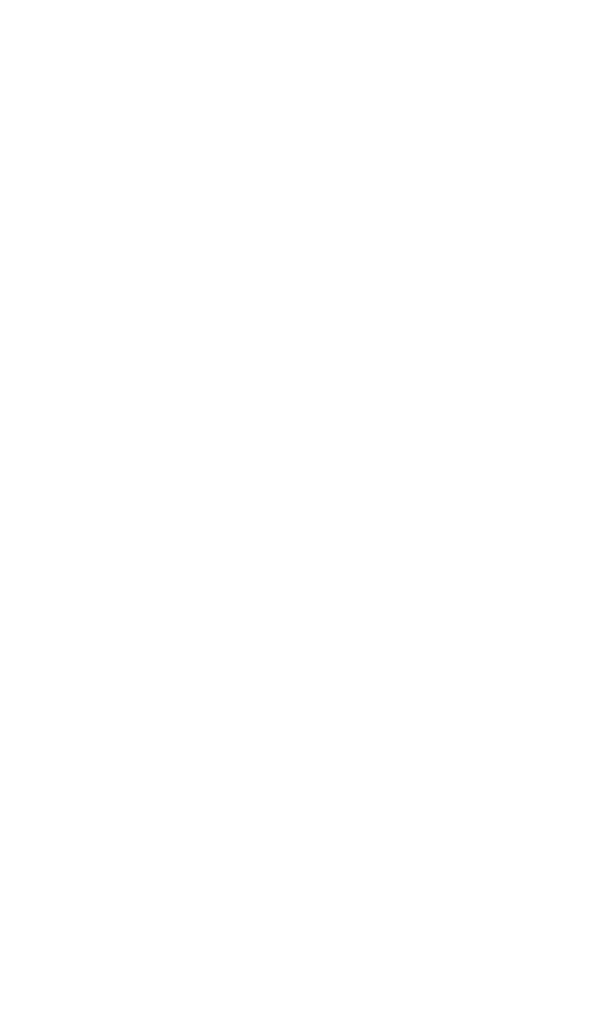
Figure 1. Yardstick for Financial Resource Allocation Based on the Global Burden Awarded to Each Disease in TDR’s Portfolio in the 2001–2002 Biennium (Top) and the 2007–2008 Biennium (Bottom). The figures show that the diseases fall into two relatively distinct groups, (i) well-funded (i.e., malaria and tuberculosis), and (ii) less well-funded, including leprosy, which is now targeted for elimination as a threat in public health. Note the particularly low amounts currently allocated to schistosomiasis and lymphatic filariasis in relation to the estimated global burden of these diseases.